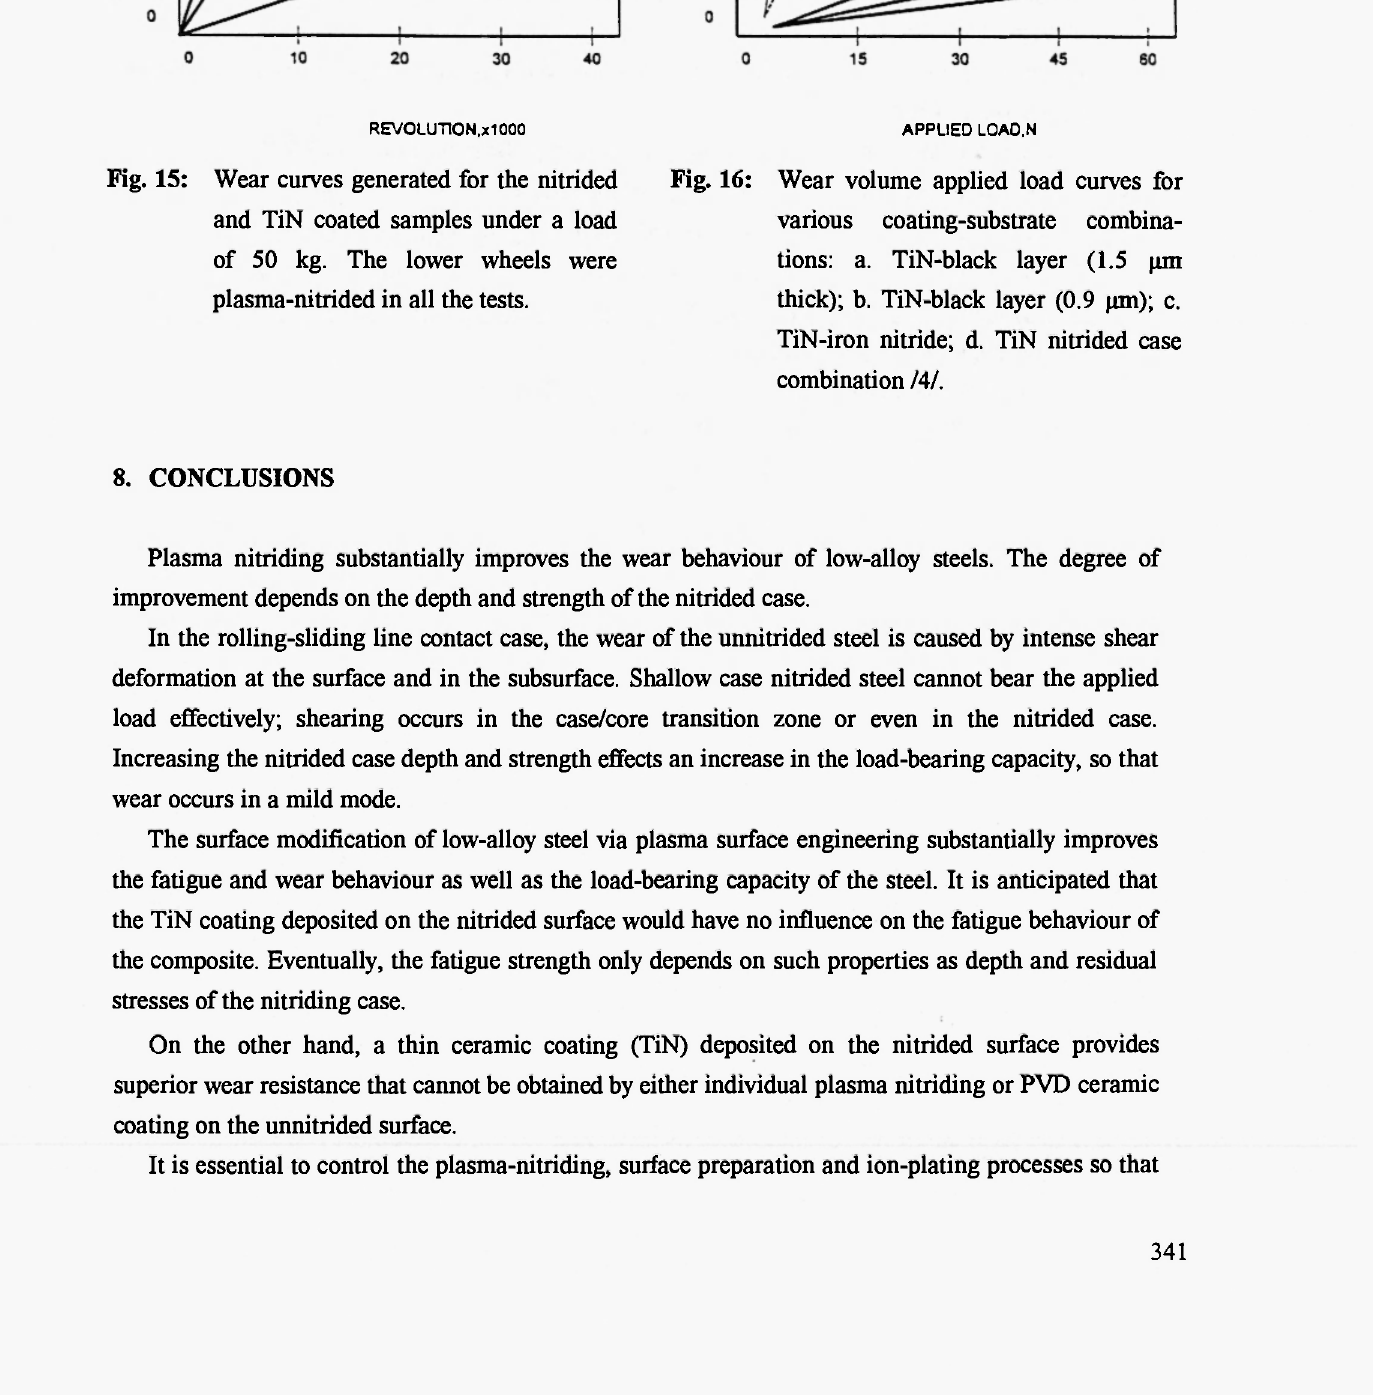
Fig. 15: Wear curves generated for the nitrided and TiN coated samples under a load of 50 kg. The lower wheels were plasma-nitrided in all the tests.